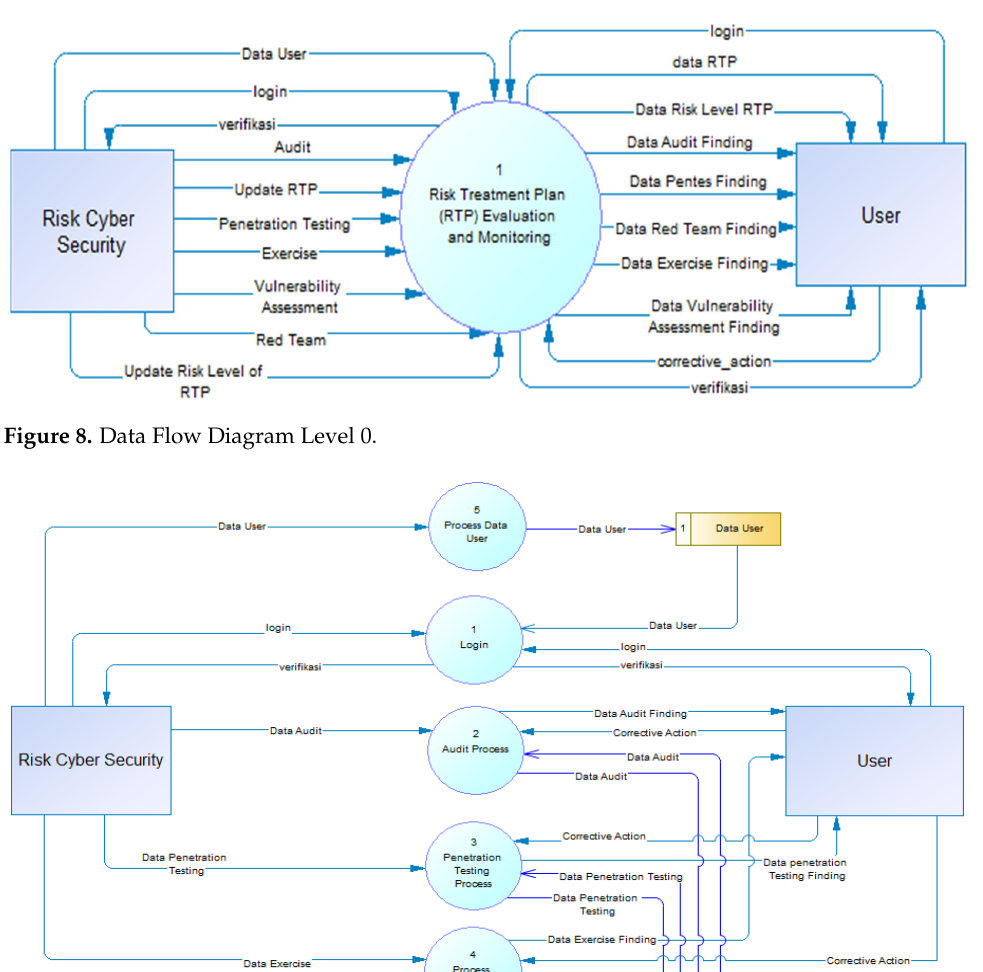
Figure 7. The Risk Management Flow Chart’s Scope of the Risk Treatment Plan Testing Architecture System.